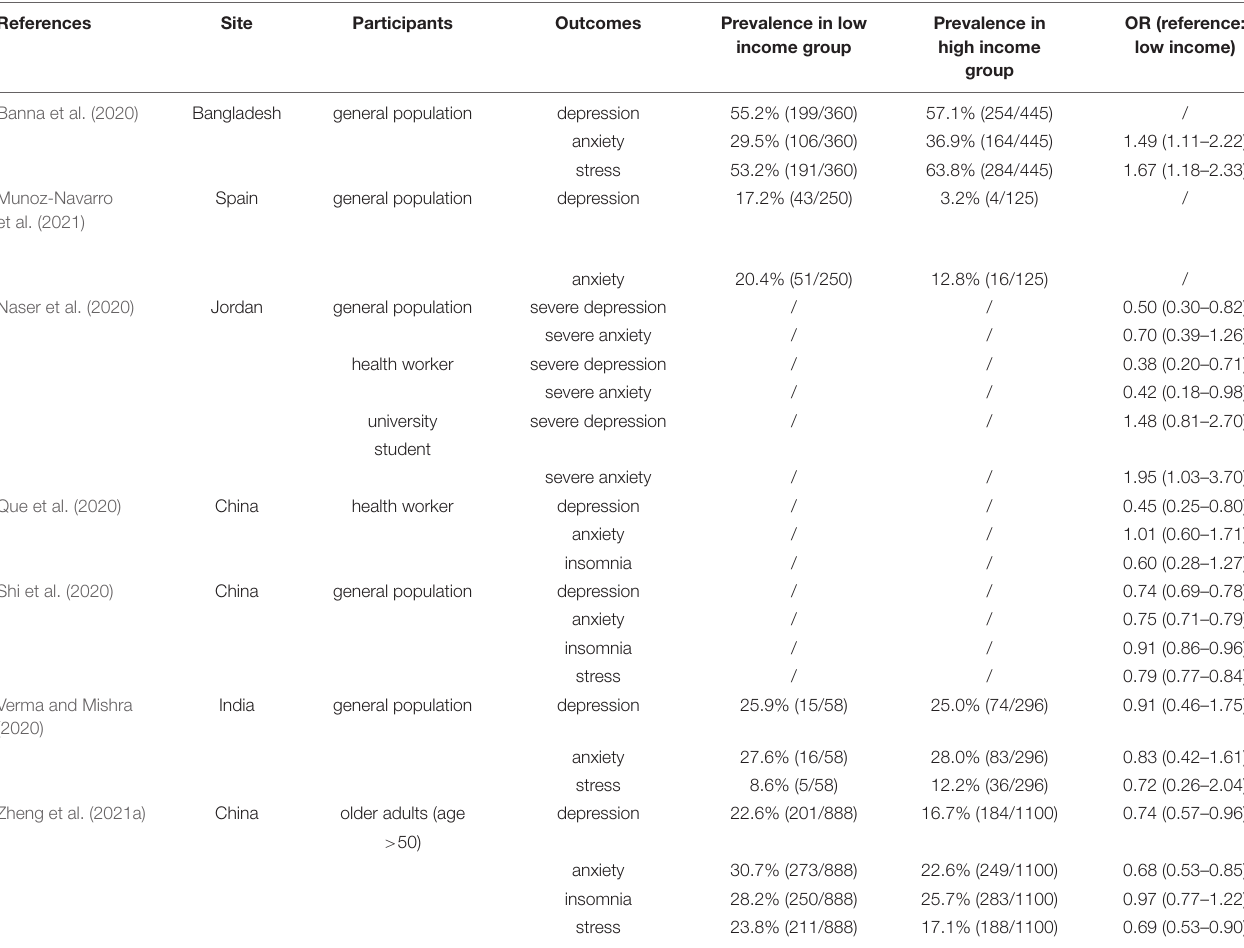
TABLE 3 | Summary of findings exploring the association between income and mental health